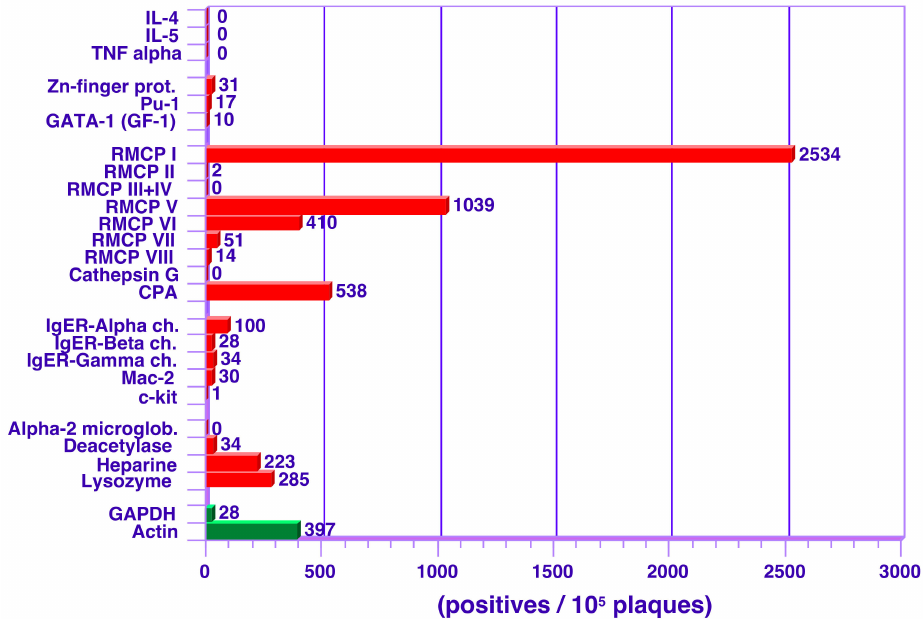
Figure 2. Transcript levels for MC-related genes in rat peritoneal MCs from an earlier study using an unamplified cDNA library [7]. The number of plaques per 100,000 clones were calculated for each of the listed transcripts. These values give an approximate value for the transcript abundance. Approximately 30% of the clones were empty indicating that the relative abundance of for example RMCP-1 was not 2.5% but closer to 3.5% of the total